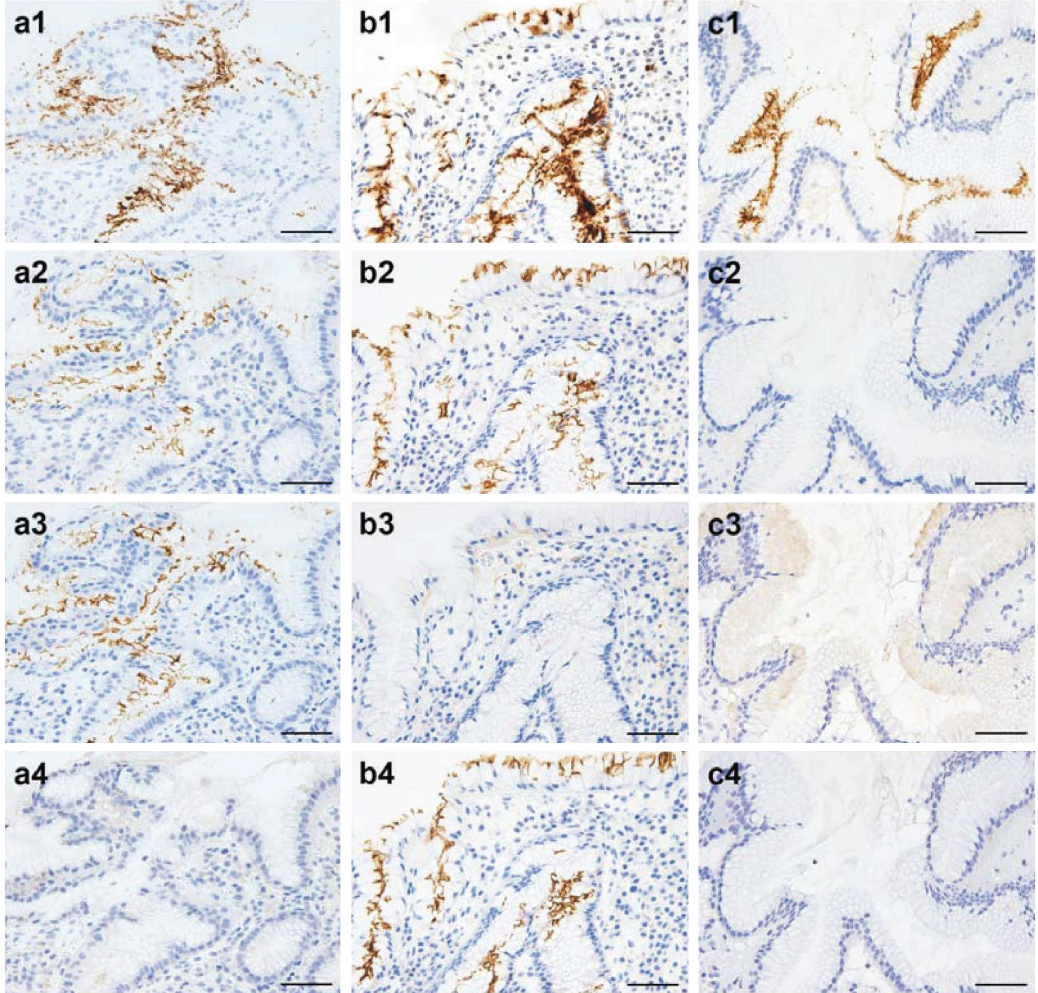
Figure 3: IHC features of H. pylori with diferent CagA status in the gastric mucosa. Representative pictures of IHC with the H. pylori mAb (1), the CagA mAb (2), the EPIYA-C mAb (3), and the EPIYA-D mAb (4) are shown pairwise for each identical gastric biopsy sample with the Western type (a), East Asian type (b), or CagA-negative (c) H. pylori infection confrmed by PCR afterward. Te novel EPIYA-C and EPIYA-D mAbs showed a prominent contrast in the presence (a3/b4) or absence (a4/b3) of signals on the surface of gastric foveolar epithelium in the CagA-positive (a2/b2) samples with H. pylori infection (a1/b1). A sample with many H. pylori (c1) and minimum infammation was CagA negative (c2) with no reactivity by the novel EPIYA-C/D mAbs (c3/c4). Bars: 50 µ m. Table 2: Detection status of both EPIYA-C and EPIYA-D motifs of H. pylori in gastric biopsy samples by IHC and PCR. Number of samples with detection of both EPIYA-C/D motifs by Detection status of both Number of samples EPIYA-C/D motifs by IHC with the IHC result